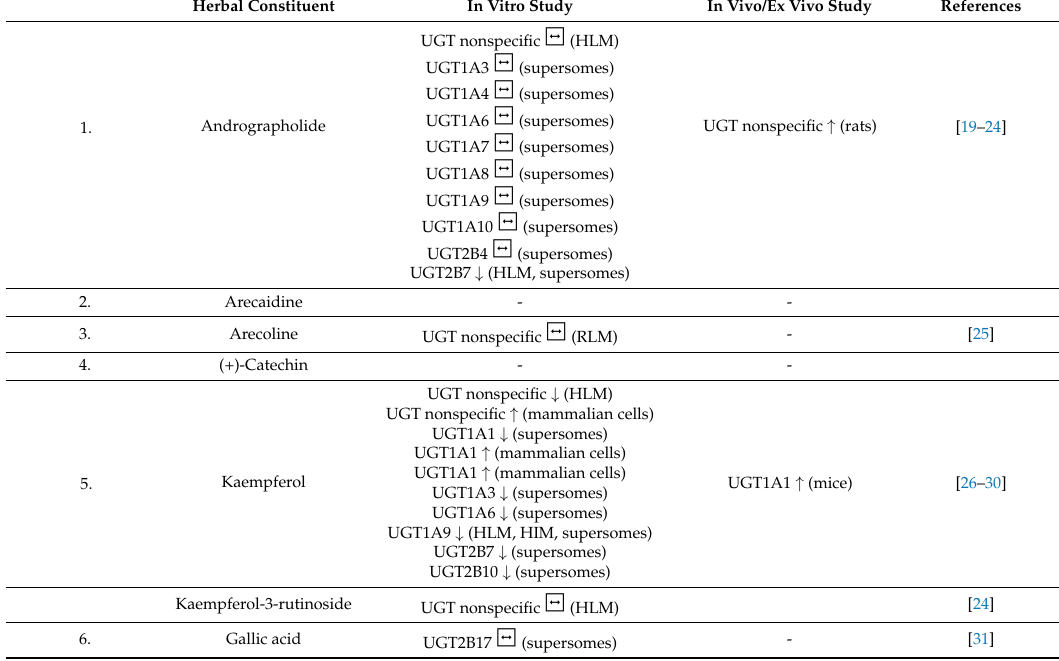
Table 1. The effect of selected herbal constituents on UDP-glucuronosyltransferase (UGT) isoforms activities. Herbal Constituent